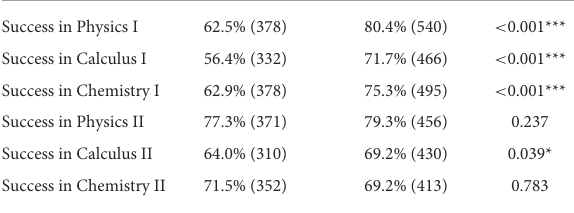
TABLE 3 Success rates for the control group and the treatment group (as a percentage and raw numbers) along with the p -values for the two proportion